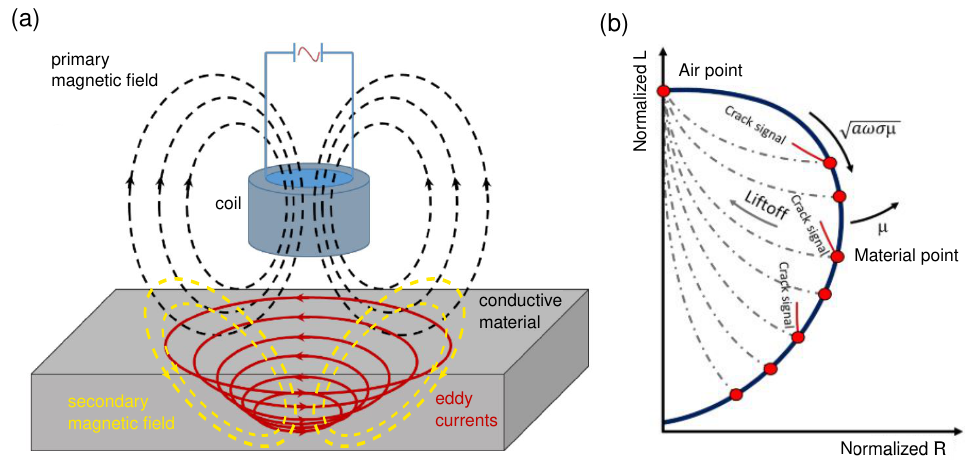
Figure 1. ( a ) Eddy current testing (ECT) measurement principle. ( b ) Impedance plane representation. Adapted from Hippert